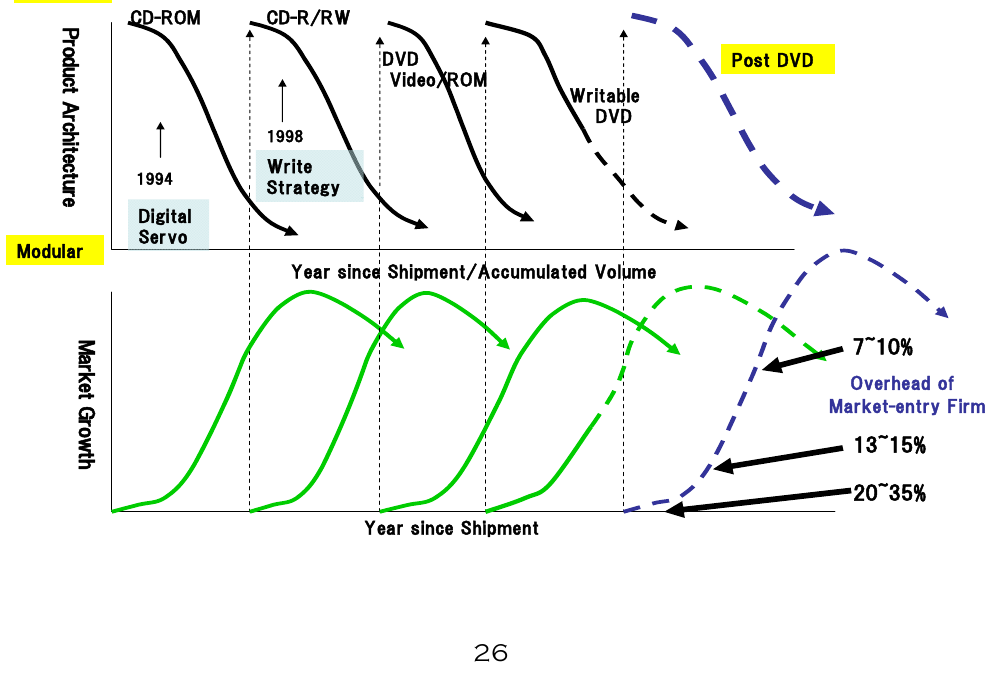
Figure 5. Dynamic Change of Product Architecture and Contribution to Market